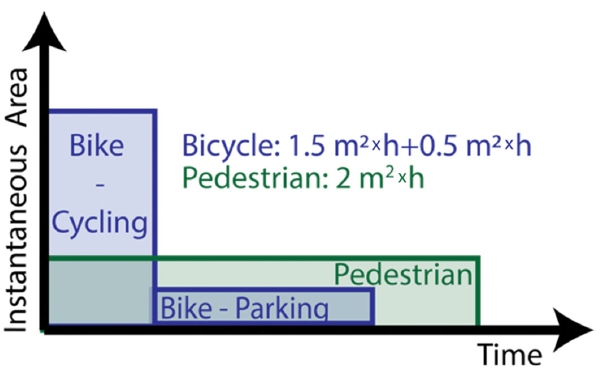
Figure 1. Time ‐ area requirements of bicycle (blue) and pedestrian (green) (source: [13]). Figure 1. Time-area requirements of bicycle (blue) and pedestrian (green) (source: